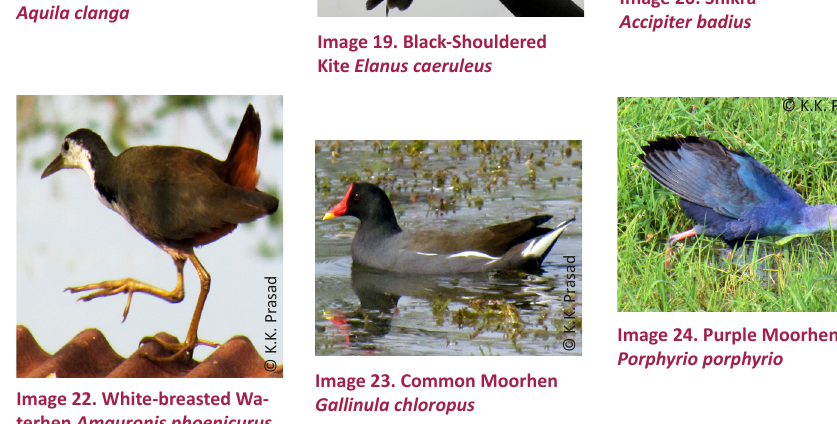
Image 21. Indian Peafowl Pavo cristatus